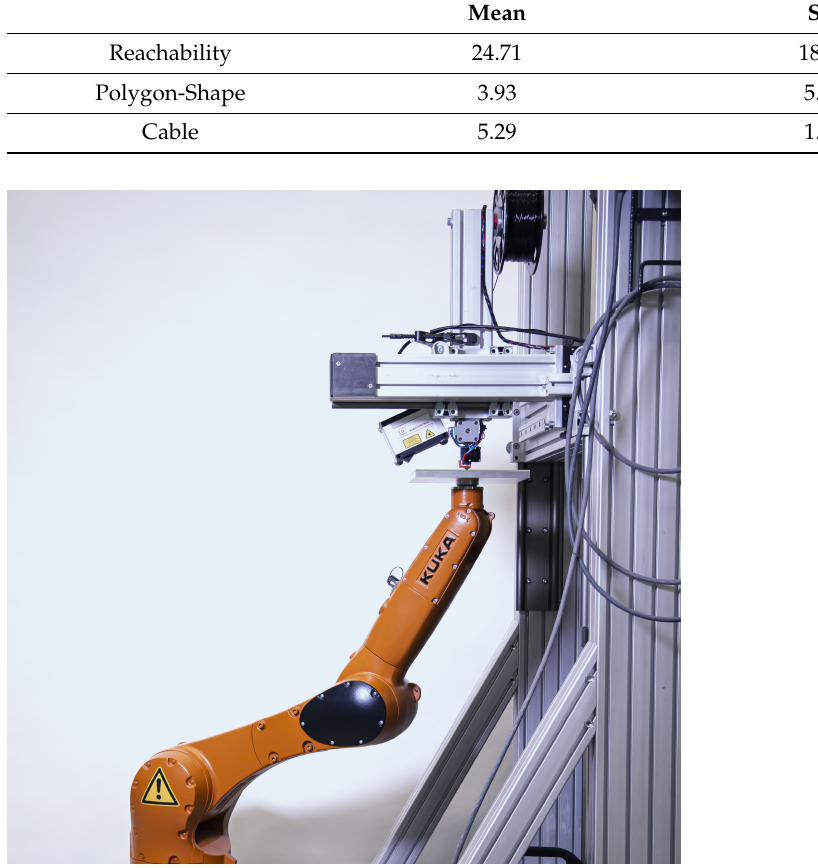
Figure 25. Prototype of MDAM process at IGMR using the FDM Process and a Laser Line Scanner for further